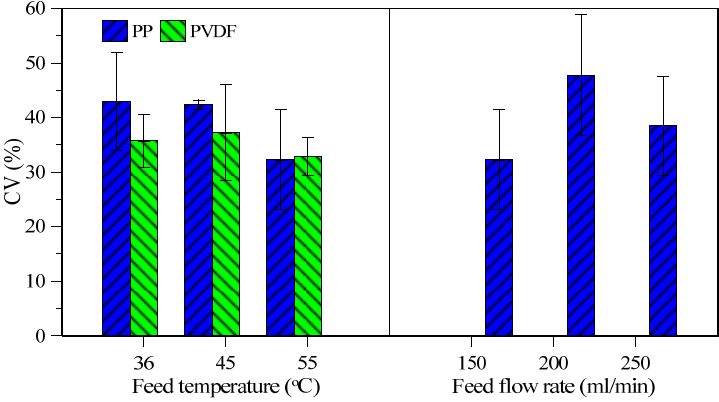
Figure 10. Coefficient of variation (CV) for lab scale modules as function of feed temperature and flow